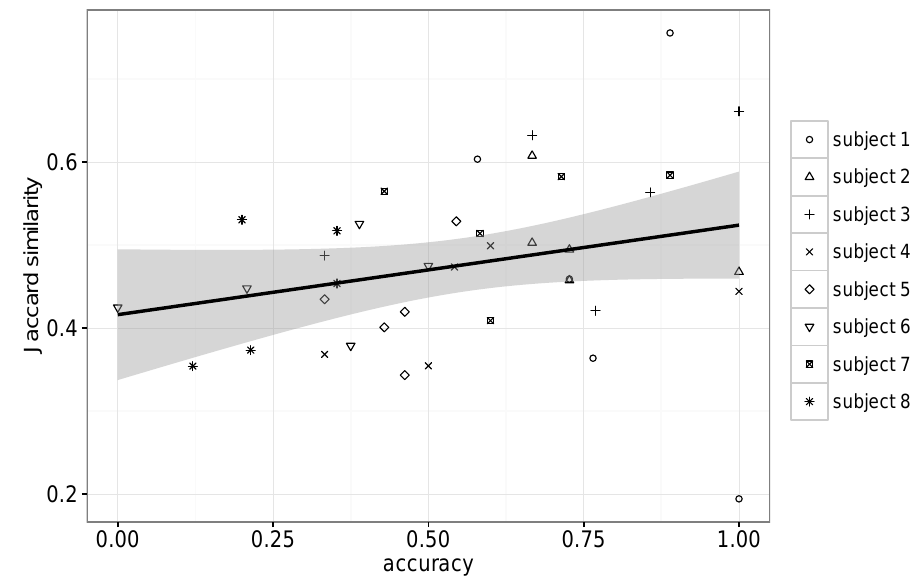
Figure 9. Scatter plot between the Jaccard similarity and the accuracy of